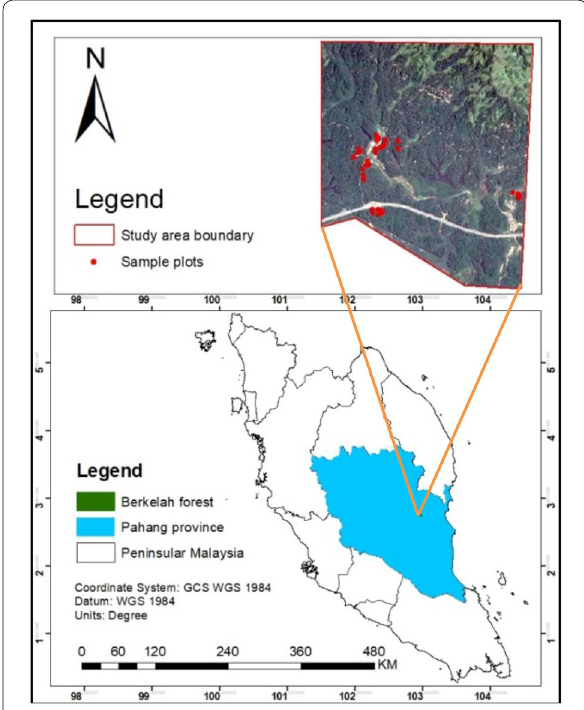
Fig. 1 Location map of Berkelah forest reserve, Pahang,